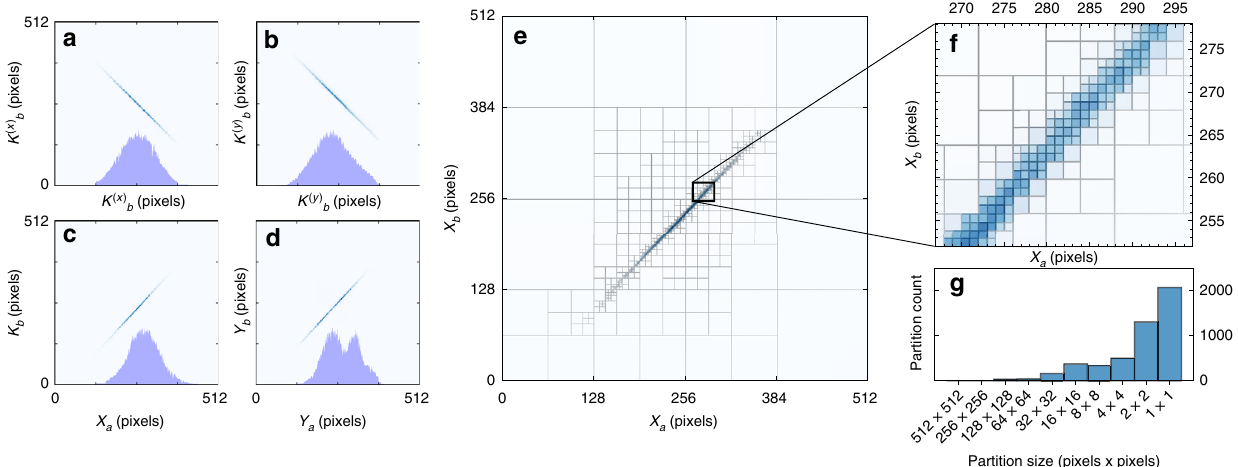
Fig. 2 Measured joint probability distributions at 512 × 512 pixel resolution. a – d show the four estimated joint probability distributions with their single- party marginal distributions overlaid, showing tight correlations. e shows an enlarged version of ~ P ð X showing a small central region to see fi ne detail. The histogram g shows the number of partitions as a function of their area. Only 6456 measurements are needed instead of 2 × 512 4